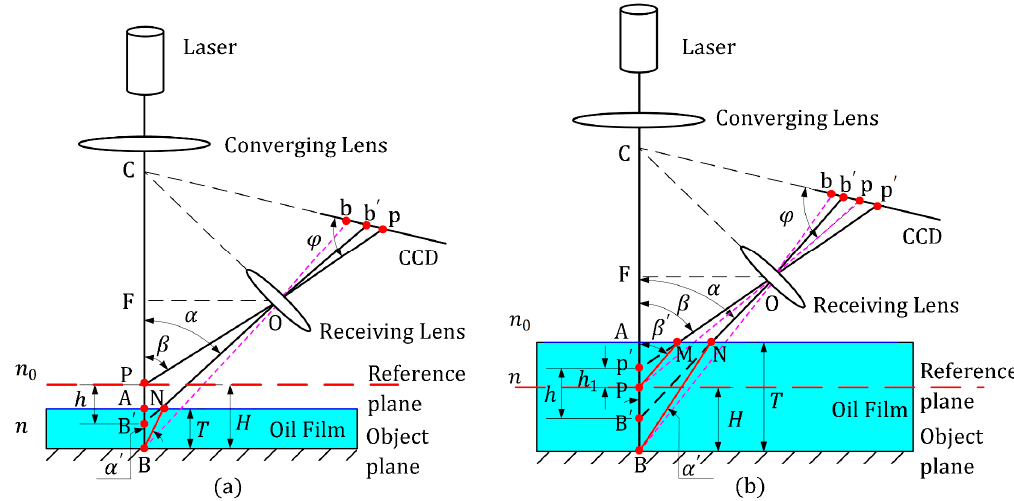
Figure 3. A schematic optical path under refraction conditions. The reference plane lies ( a ) above the oil film and ( b ) in the oil film.